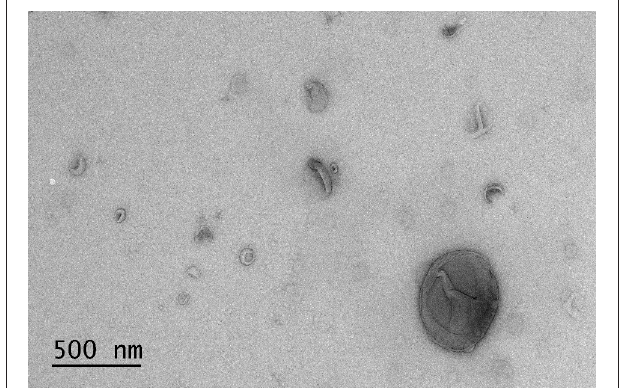
FIGURE 1 | Mean protein concentration in extracellular vesicle sample fractions from three horses isolated by size-exclusion chromatography. The protein concentration was analyzed with the bicinchoninic acid assay.